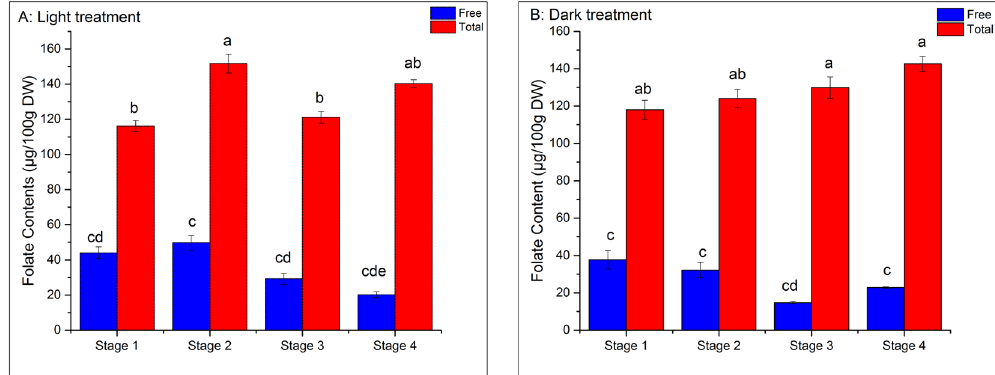
Figure 6. Changes of Folates during sweet corn seed germination; Bars with different letter indicates significant difference ( p < 0.05) exists within groups. ( a ) Light treatment; ( b ) dark treatment. Free means readily extracted folate, which is obtained by free-enzyme extraction after autoclaving.